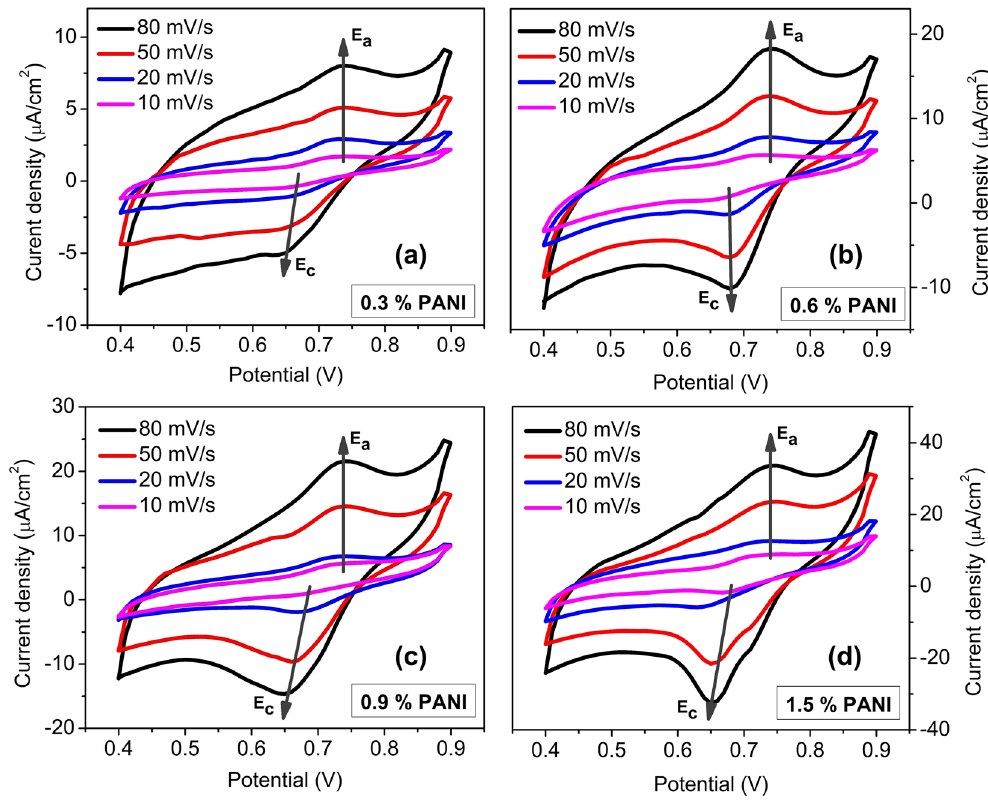
Figure 8. Cyclic voltammograms of conductive scaffolds at different scan rates of ( a ) 0.3% PANI, ( b ) 0.6% PANI, ( c ) 0.9% PANI and ( d ) 1.5% PANI.